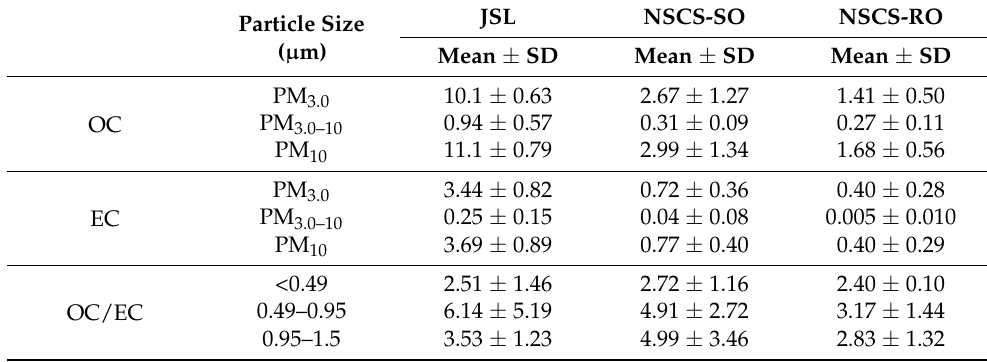
Table 1. OC and EC concentration ( µ g m − 3 ) and the ratio of OC/EC in fine and coarse particles. JSL Particle Size ( µ m)